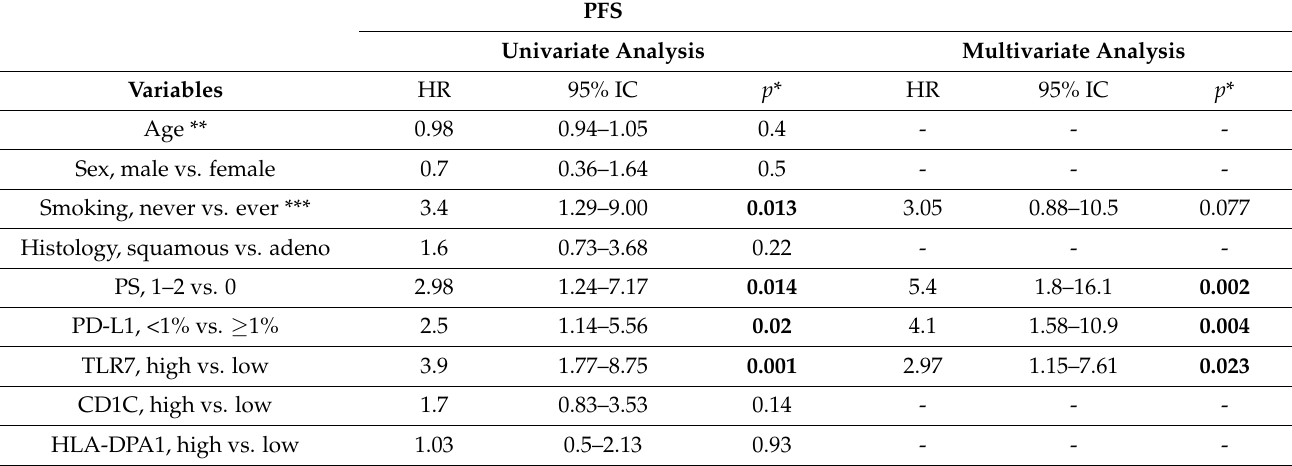
Table 5. Univariate and multivariate Cox analyses for progression-free survival (PFS).